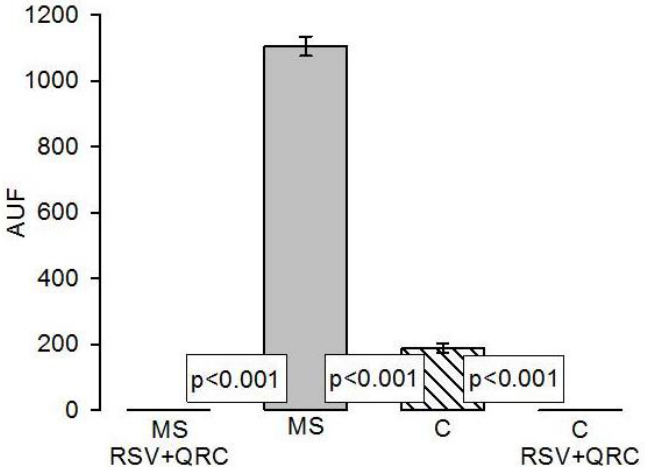
Figure 2. Histogram that represent the Lipid detection from rat liver cryosections stained with oily red (OR) and imaged using transmitted light (TL), contrast phase and red fluorescence channels on the FLoid ® Cell Imaging Station. Abbreviations: AUF Arbitrary units of fluorescence calculated with the image-pro program in an Olympus fluorescence microscopy.